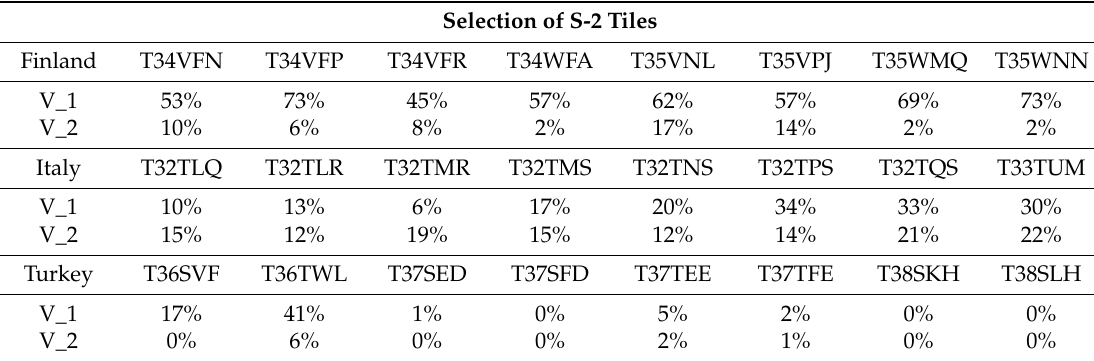
Table 3. Selection of S-2 tiles at each test site and characterization of vegetation cover according to GlobCover 2009 land cover map. Two main vegetation classes having high (V_1) and medium (V_2) impact on snow detection are reported.